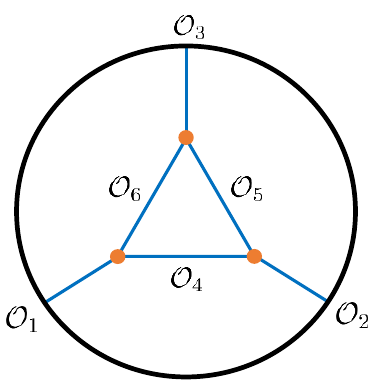
Figure 7. The AdS three-point triangle, A 1 (cid:0) loop